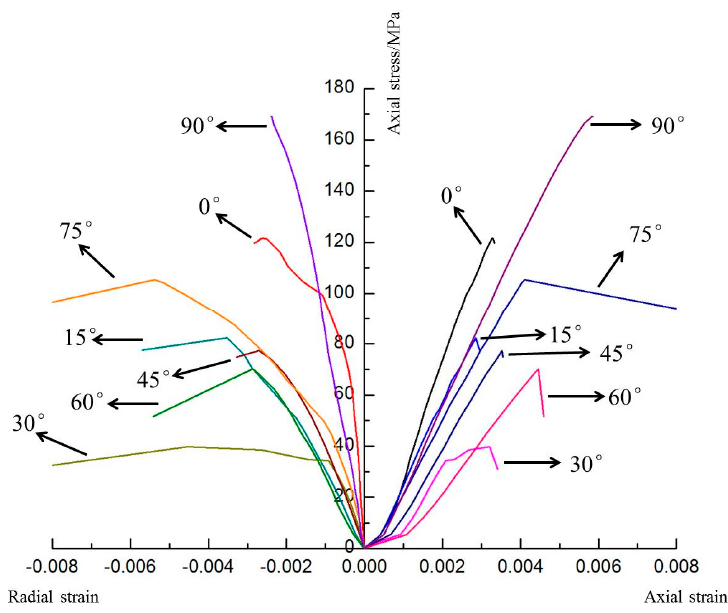
Figure 6. Stress-strain curves for shale subject to uniaxial compression.